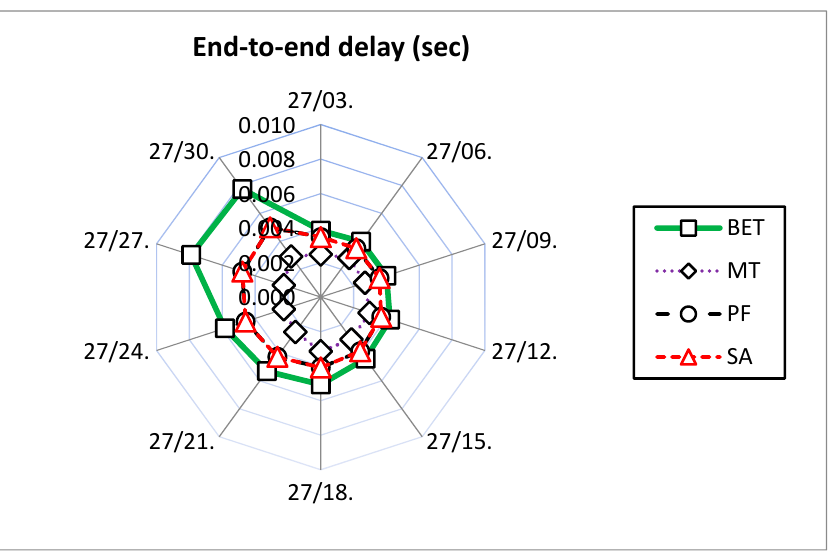
Figure 12. Average packet end-to-end delay for video far users in mixed traffic.